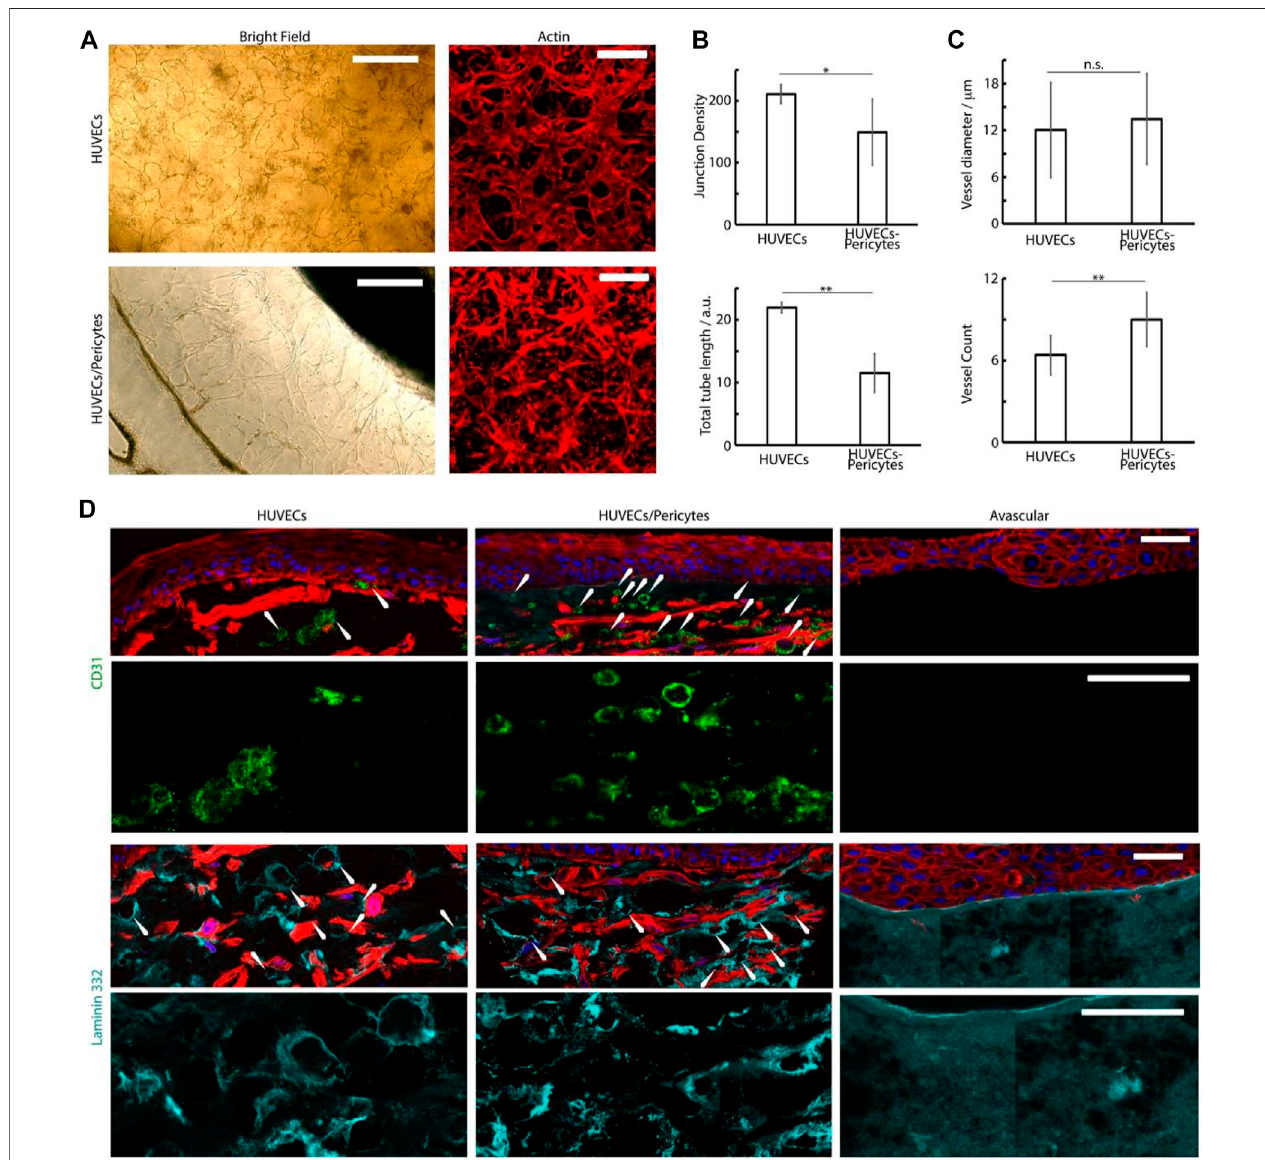
FIGURE 7 | (A) Bright fi eld and confocal images (phalloidin) of the basal microvascular compartment of chips injected with either HUVECs alone or HUVECs and pericytes,followed by4 days ofculture in EGM2medium +50 ng/mlVEGF and 2 weeksin FAD medium. Scale bars: 200 μ m. (B,C) Characterization ofthe morphology of the corresponding networks. Junction density and total vessel length are expressed in arbitrary units normalised by the section area. (D) Histology sections of microvascularizedskin-on-chipconstructsimmuno-stainedwithphalloidin(red),DAPI(blue),andforCD31(green)andlaminin332(cyan).Tissueswereculturedfor 14 days in submerged conditions. Scale bars: 50 μ m. * p < 0.05; ** p < 0.01; n.s., non-signi fi cant, p > 0.05; error bars are standard errors; n =